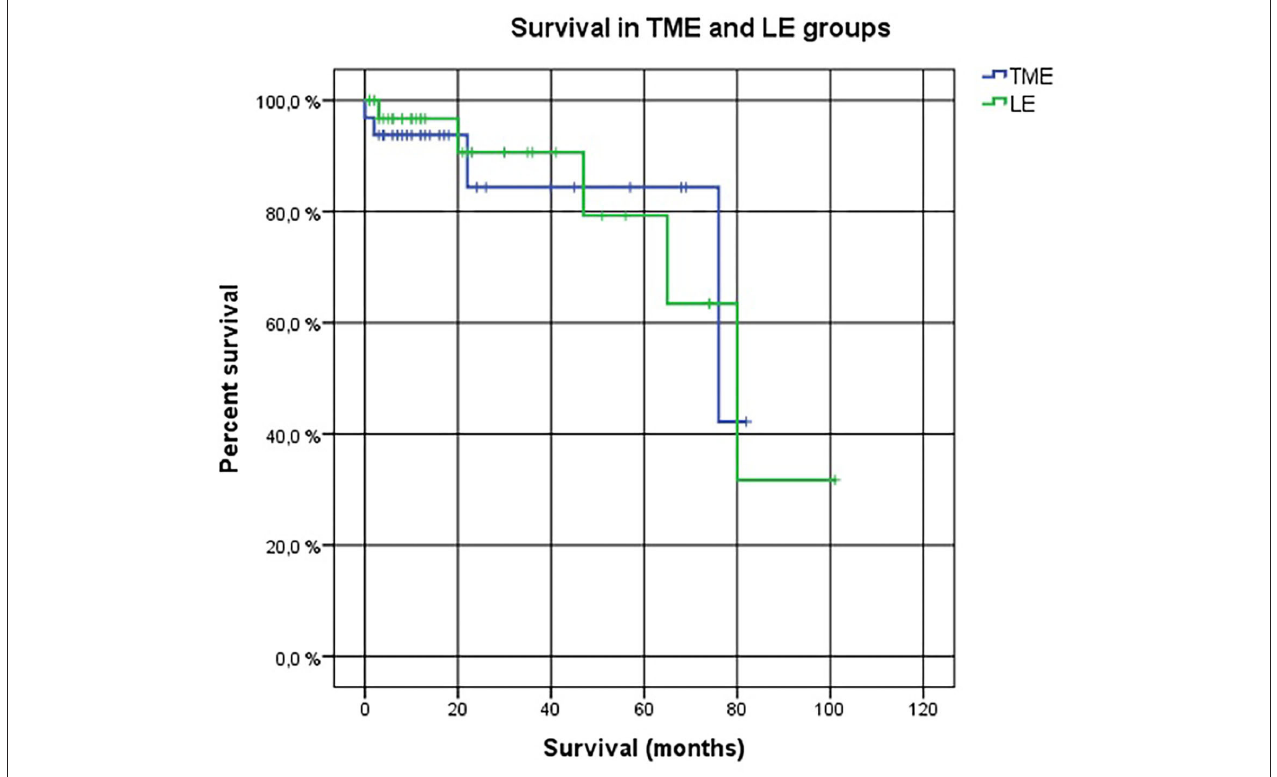
FIGURE 2 | The Kaplan–Meier Cox diagrams for evaluating survival in two groups. Log Rank (Mantel-Cox) p -value = 0.964. LE, local excision. TME, total mesorectal excision.